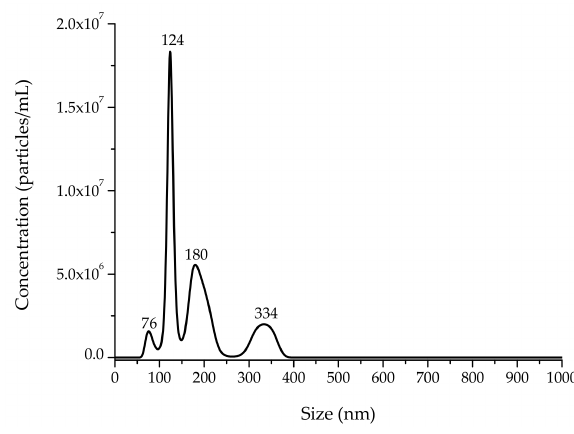
Figure 5. Particle number concentration and particle size distribution of synthesized ZnO nanoparticles.